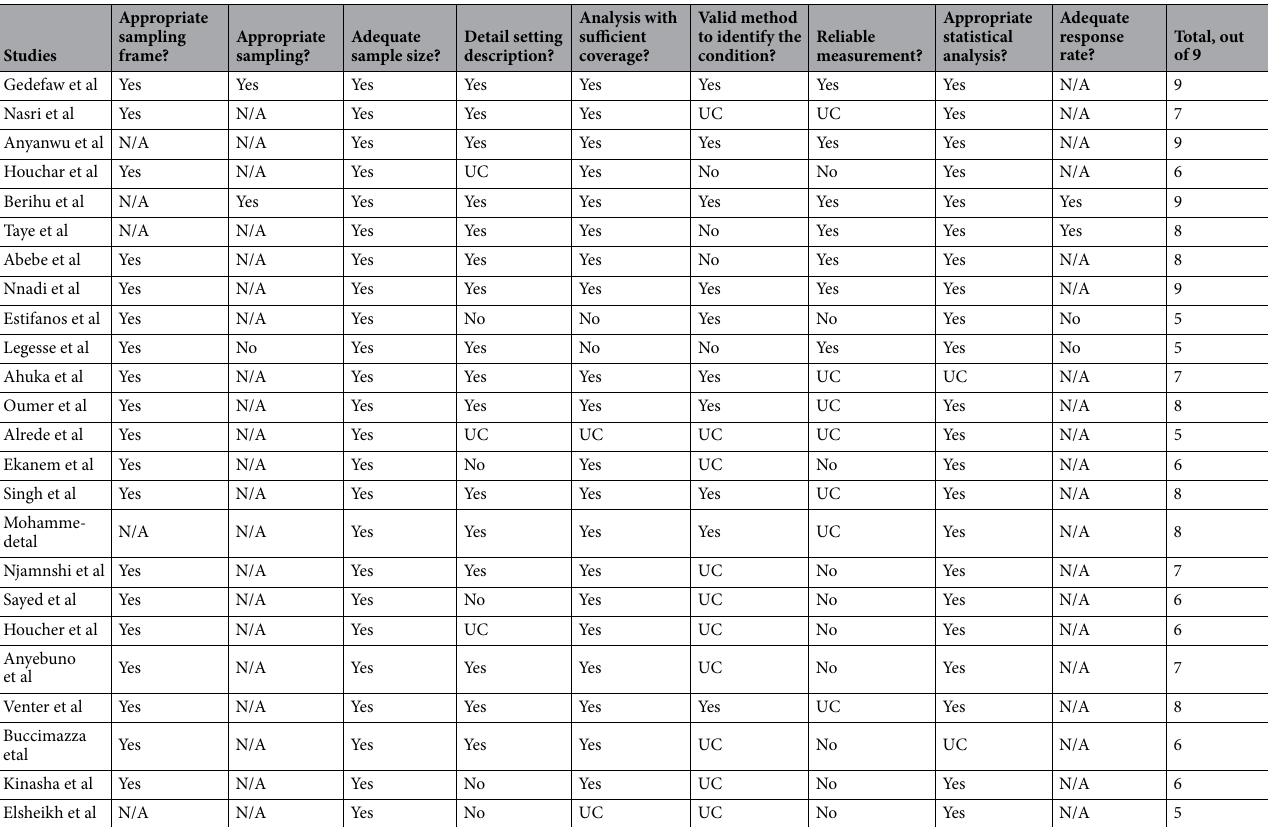
Table 3. The quality status of studies based on JBI critical appraisal checklist for studies reporting prevalence data, 2020. Key: UC: Unclear, N/A: Not Applicable. N/A for appropriate sampling means the study included all participants rather than sampling methods; N/A for adequate response rate means the study considered all recorded cases from all participants, so it is adequate; UC means it may be considered but not explicitly stated in the manuscript. For adequate sample size, as all participants were included in the study during the study period, we considered an adequate sample size even if they did not calculate sample size (it is a total